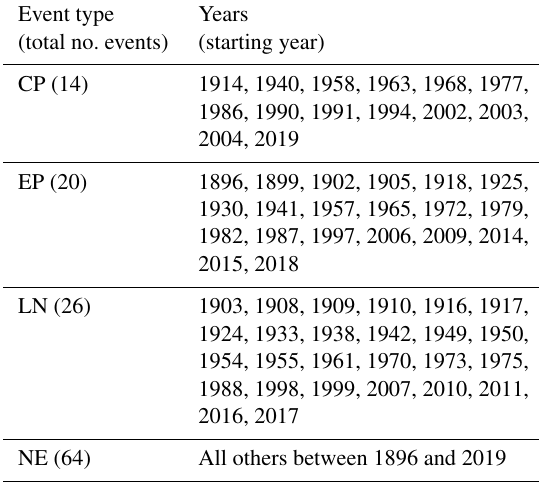
Table 1. Years which are defined as central Pacific (CP) and east- ern Pacific (EP) El Niño events, La Niña events (LE), and neu- tral (NE) events in the observational data. These years are found following Pascolini-Campbell et al. (2015) for CP years, https: //www.psl.noaa.gov/enso/ (last access: 22 August 2022) for events 1896–2014 and https://origin.cpc.ncep.noaa.gov/products/analysis_ monitoring/ensostuff/ONI_v5.php (last access: 22 August 2022) for events 2014–2019, and https://www.pmel.noaa.gov/tao/drupal/ disdel/ (last access: 22 August 2022) to determine whether the 2019 El Niño was a CP